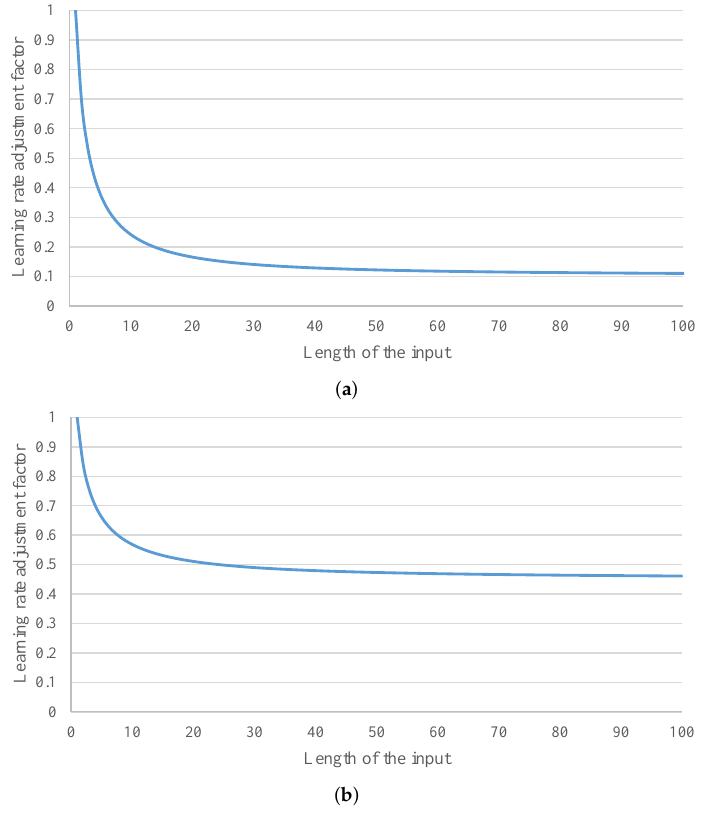
Figure 4. Illustration of the learning rate adjustment factor over different lengths of inputs for the first 1, 2, ..., L − 1 IndRNN layers (learning rate adjustment factor versus length of the input). ( a ) Learning rate adjustment factors for neurons with recurrent weight 1; ( b ) average learning rate adjustment